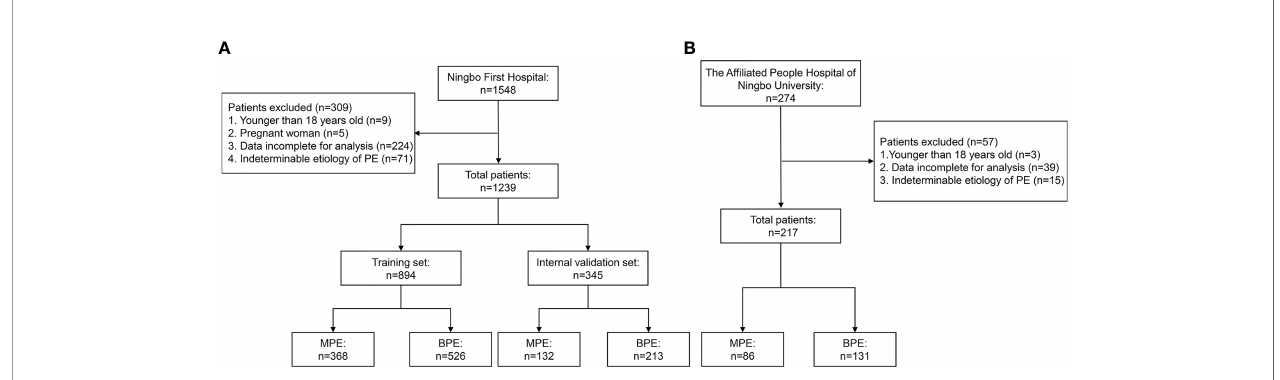
FIGURE 1 | Flowchart of the study participants. (A) Ningbo First Hospital set. (B) The Af fi liated People Hospital of Ningbo University